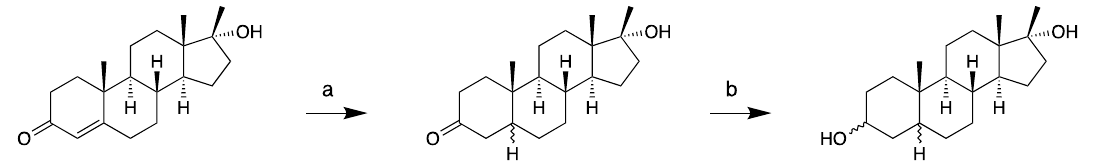
Figure 6. Synthesis route for 17 β -methyl-5 β -androstane-3 α ,17 α -diol ( 11 ).